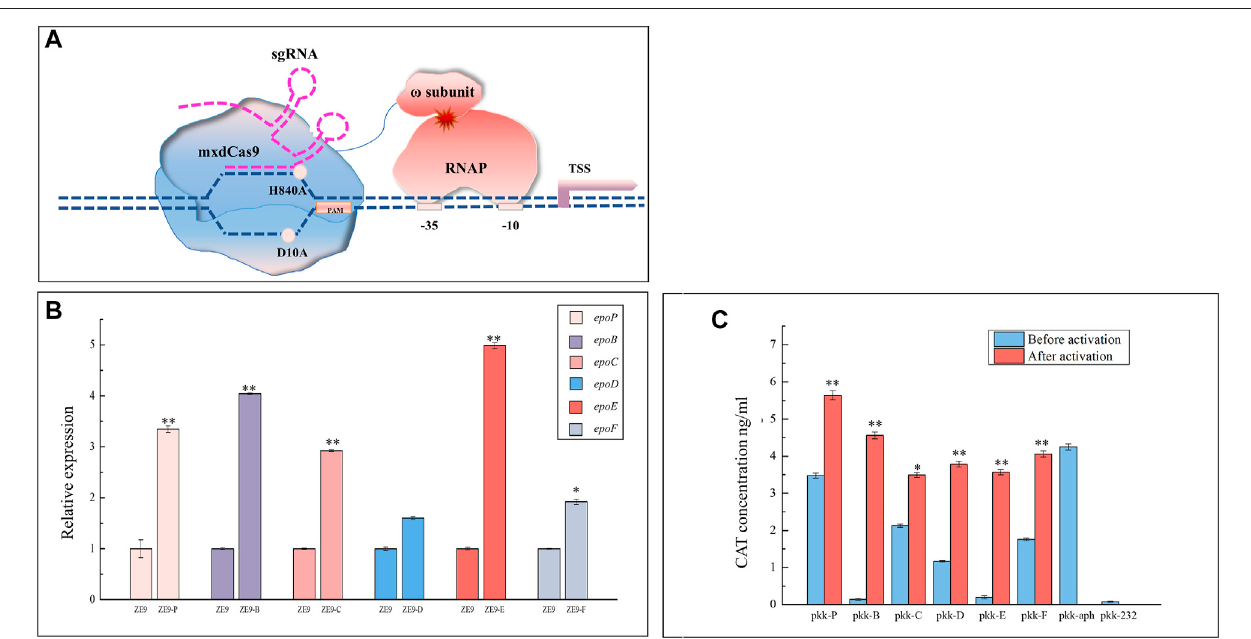
FIGURE 2 | Activation of internal promoters. (A) Principle of CIRSPR-dCas9 activation. mxdCas9: codon-optimized inactivated dCas9 protein (H840A, D10A); ɷ subunit: the Omega subunit ofRNA polymerase; RNAP: RNApolymerase; sgRNA: single guide RNA sequence, a combination ofthe CRISPR-associated RNA (crRNA) and the trans-activation crRNA (tracrRNA). (B) RT-qPCR analysis of expression levels of the six operon genes activated by internal promoters in different mutants of M. xanthus ZE9 after 48 h of incubation. The gene expressions in M. xanthus ZE9 were each set as 1, and the expressions of the operon genes in mutant strains are shownastherelativeexpression. (C) Activitiesoftheseparateinternalpromoters in E.coli beforeandafteractivationbyCRISPRa.TheCATactivitiesweredetectedwith the aphII promoter as a positive control and the original plasmid pKK-232 (no promoter upstream of the reporter gene CAT ). The aphII promoter was not activated. The errorbarsin (B,C) representthestandarddeviationofthreeindependentexperiments.Forstatisticalanalysisbetweentheancestralstrainandmutantstrains,thesignals of ** and * mean p < 0.01 and p < 0.05,